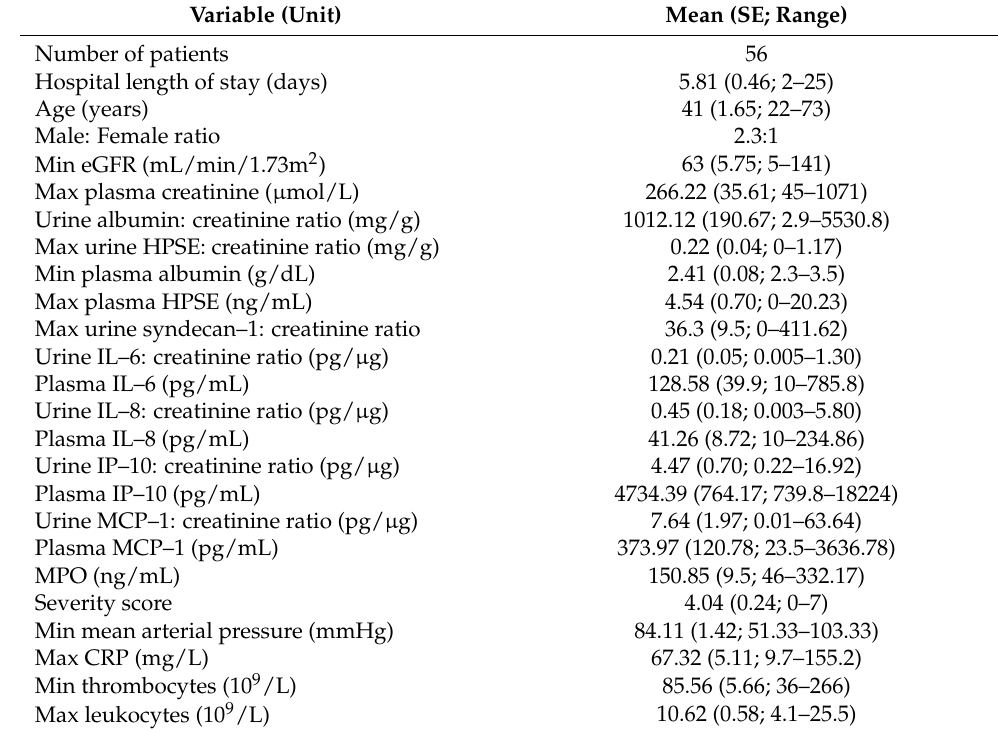
Table 1. Clinical and laboratory parameters of PUUV–HFRS patients. Abbreviations: eGFR =